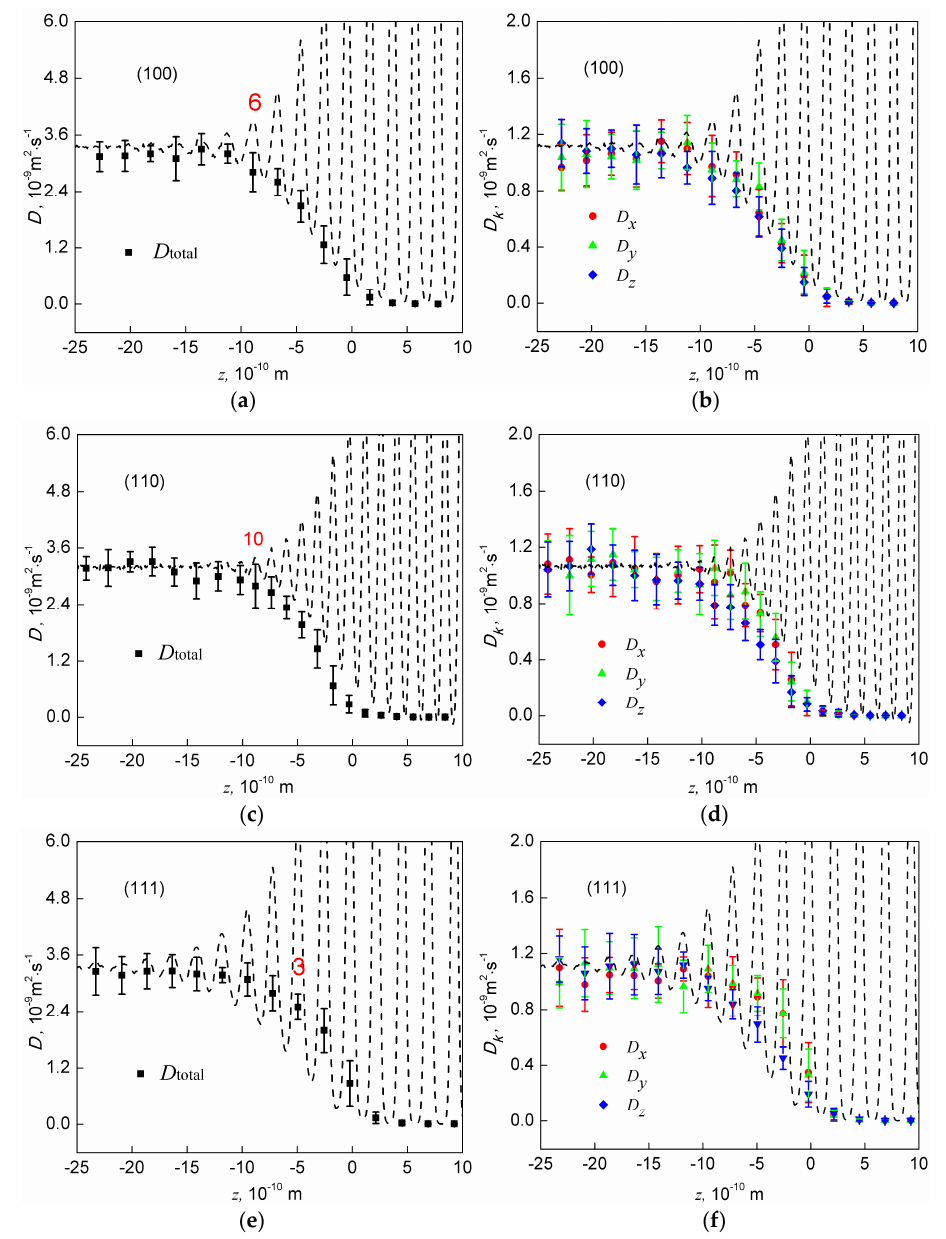
Figure 5. The diffusion constant profiles at the (100), (110), and (111) interfaces. Left panel ( a , c , e ): total diffusion constant profiles. Right panel ( b , d , f ): profiles for the three components of the diffusion constant. Distribution of atoms (dash lines) are attached to show the positions of the layers. Error bars represent standard deviations.